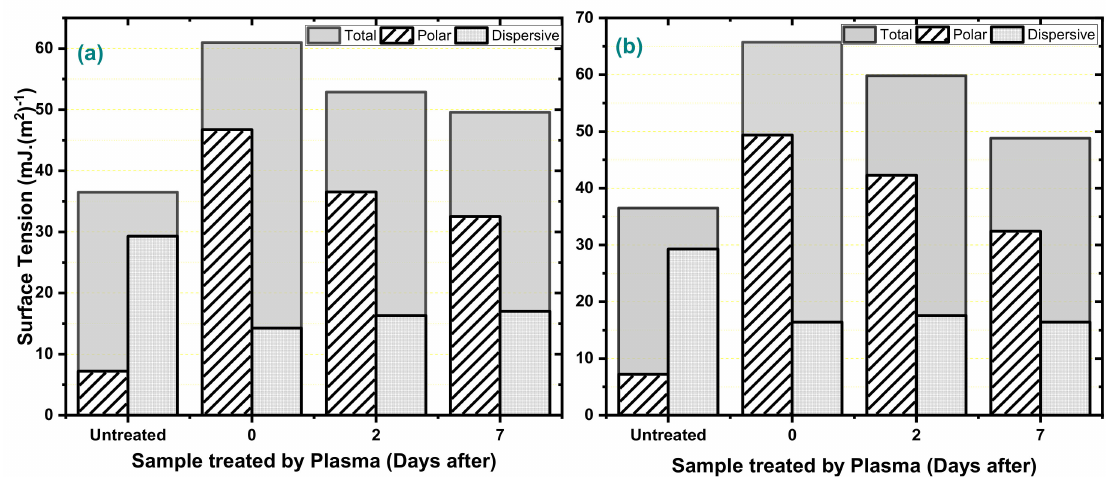
Figure 5. HDPE superficial tensions over time in ( a ) argon and ( b )